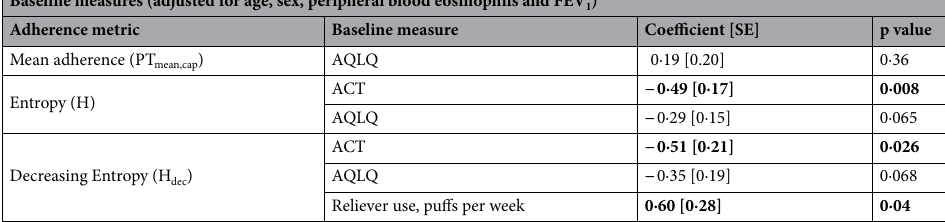
Table 2. Multivariable analysis relating adherence metrics to baseline clinical characteristics. Adherence metrics and baseline measures reported here are those which showed significant associations in univariate analyses. AQLQ Asthma quality of life questionnaire, ACT asthma control test.